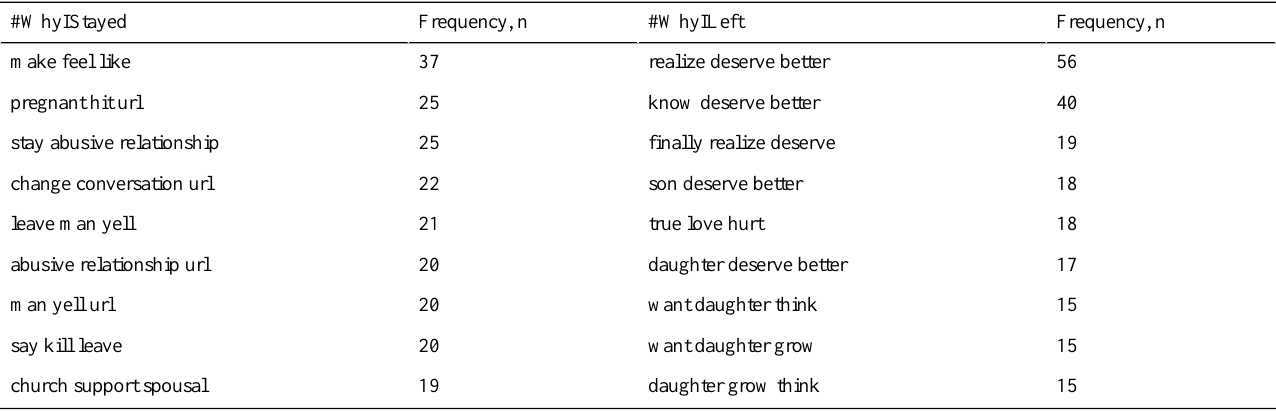
Table 4. Top 9 most frequent trigrams after preprocessing, with their respective frequencies in the Twitter devset. The number in each cell indicates the number of times the trigram appeared in the